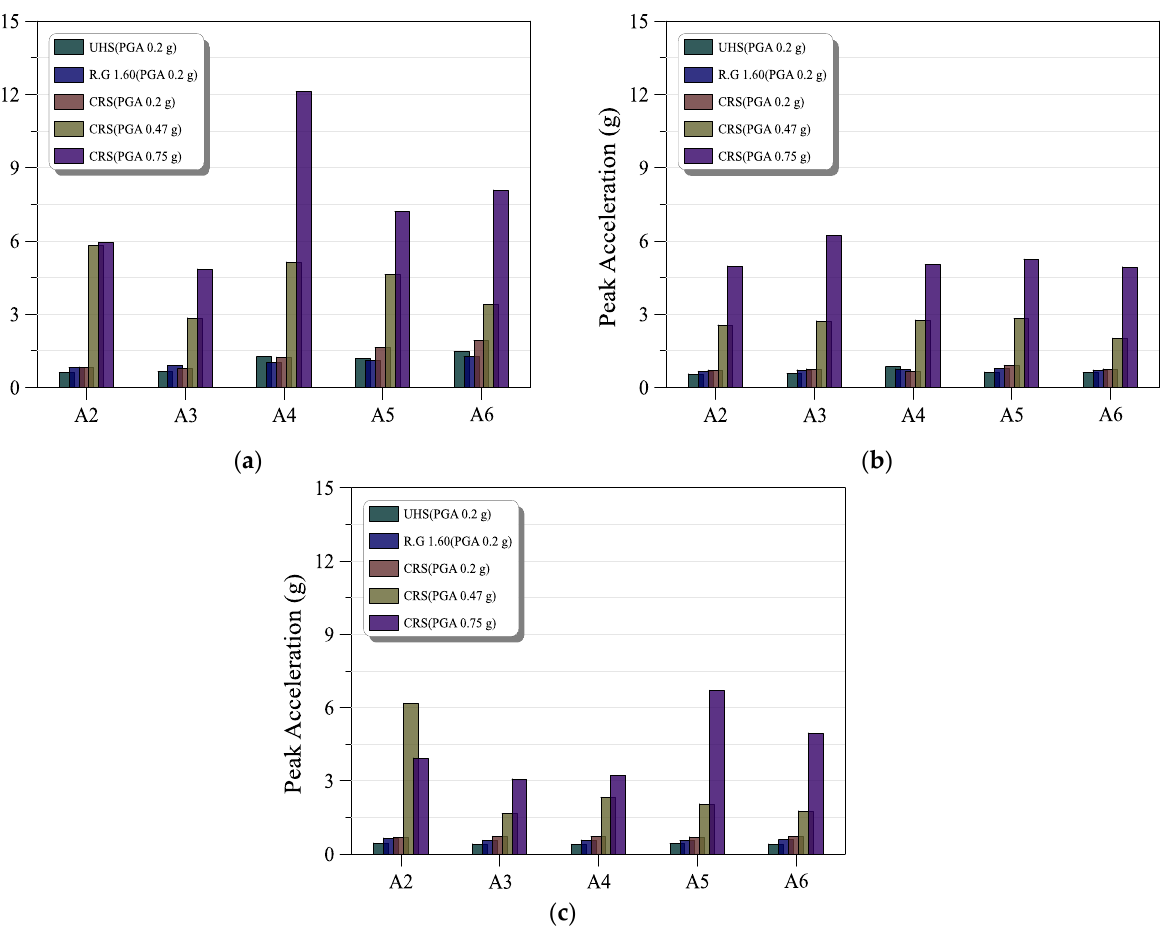
Figure 9. Comparison of in-structure peak accelerations depending on input motion: ( a ) side to side, ( b ) front to back, and ( c ) vertical.